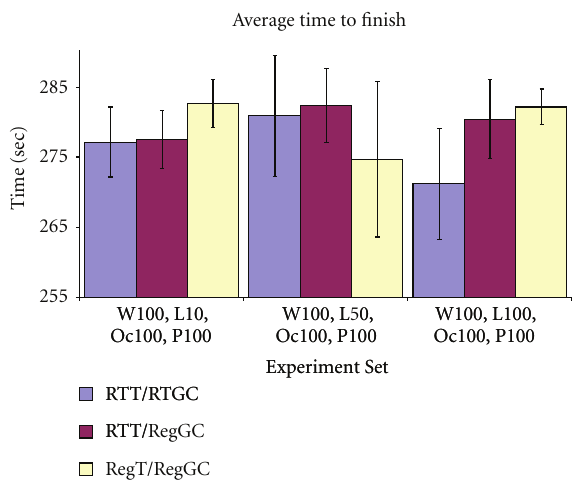
Figure 8: The average distance the robot came to the ending position for group